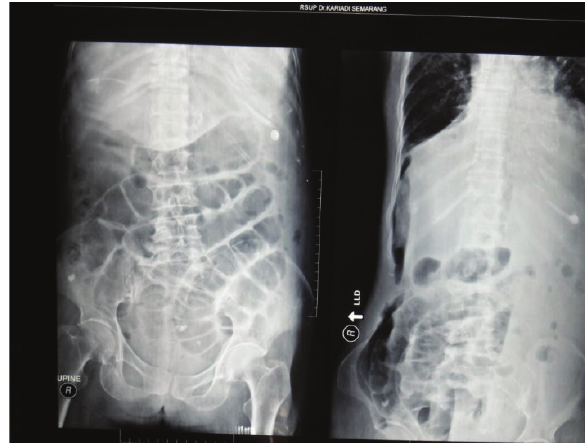
Figure 1. Abdominal X ray (AP and LLD position) Figure 2. Partial strangulated ileum of right femoral